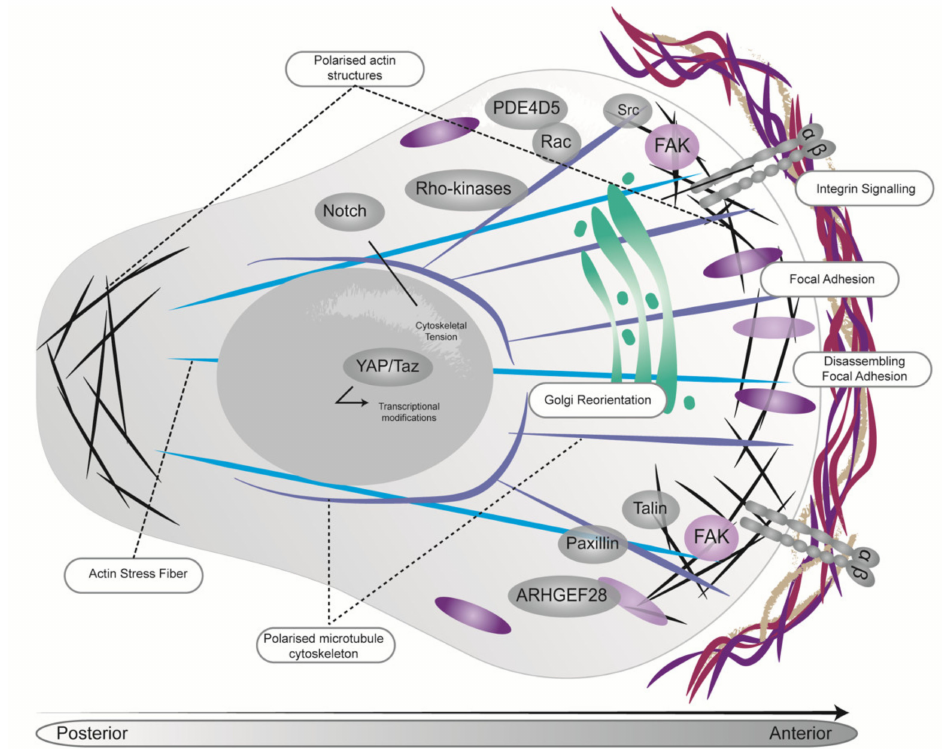
Figure 3. Biomechanical changes in PDAC. Cell-ECM signaling during tumor invasion and migration is sensed and regulated by mechanoreceptors such as integrins. Integrin-stimulated mechanosignal- ing via the FAK/Src signaling axis leads to downstream activation of Rac, Rho-kinases, Paxillin and Talin. Alteration of these pathways influences Golgi reorientation to the leading edge of migrating cells, polarization of the microtubule and actin cytoskeletons as well as actin stress fibres to establish an anterior-posterior gradient, driving cell